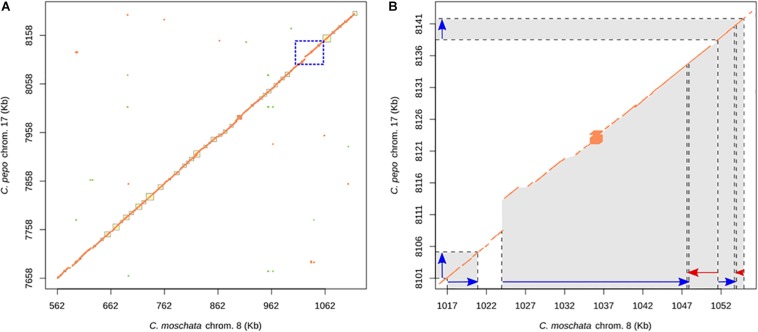
(A) Dot plot showing the alignment between the chromosome 8 of C. moschata assembly v.1 and chromosome 17 of C. pepo v.4.1. (B) Expanded syntenic region where large INDELs have been detected. Blue and red arrows points genes sense.